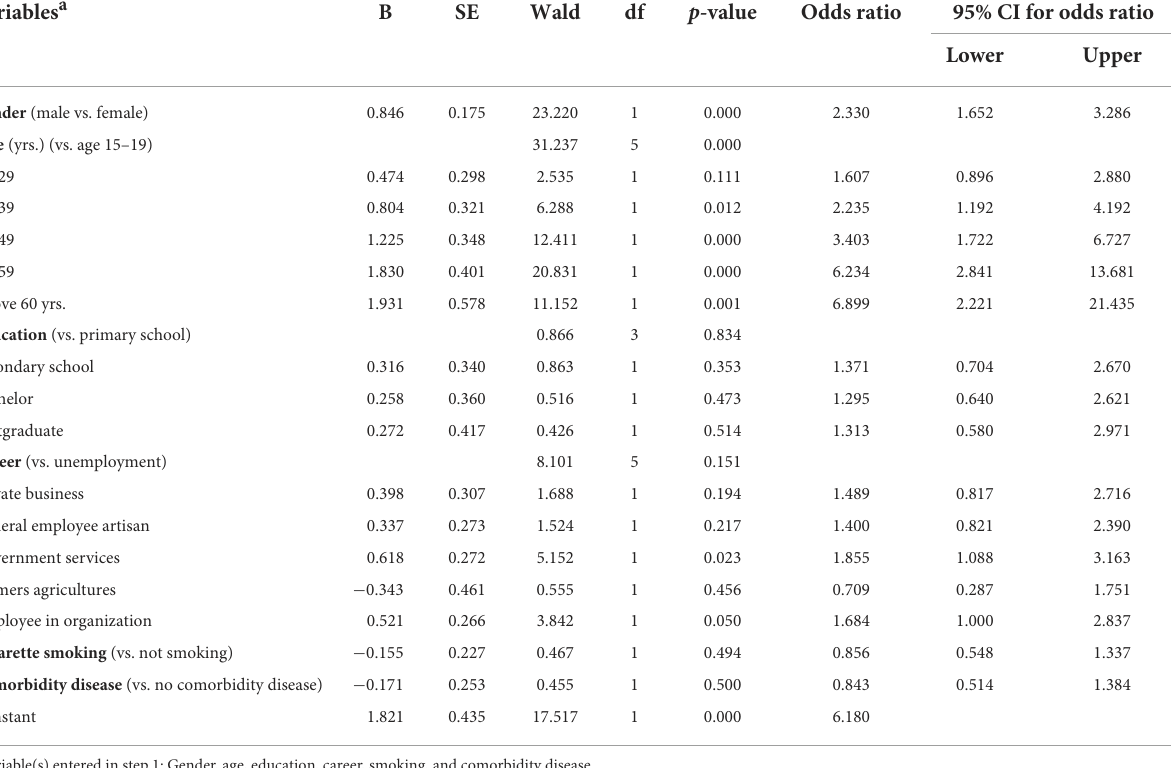
TABLE 2 Binary logistic regression results.